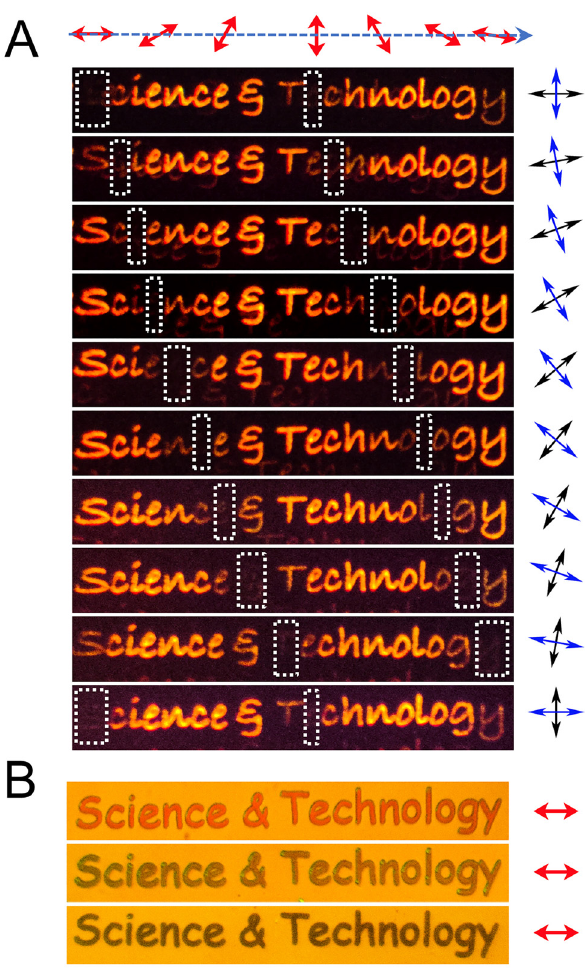
Figure 4: Optical memory realized by using